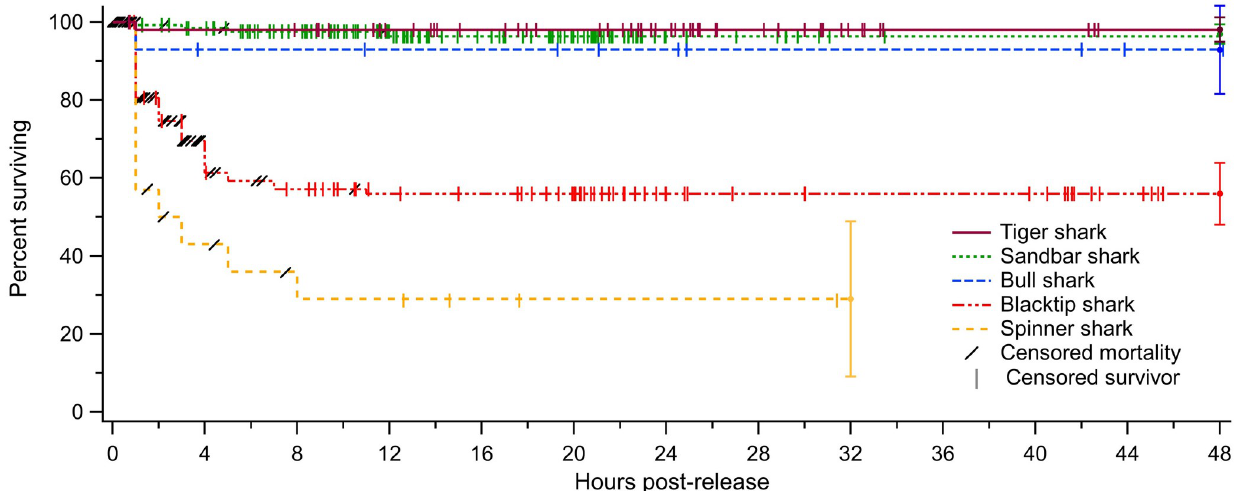
Fig 2. Kaplan-Meier survival curves for the five species of large coastal sharks tagged in the current study. Traces show the probability of mortality for the first 48 hours post-release for each species (spinner sharks were only monitored up to 31 hours post-release). The majority of mortalities occurred within the first hour post-release, and all mortalities occurred within 12 hours post-release. The error bars at the end of each curve show the 95% confidence intervals of the final estimated mortality rate for each species, calculated using equations set by Goodyear (2002).